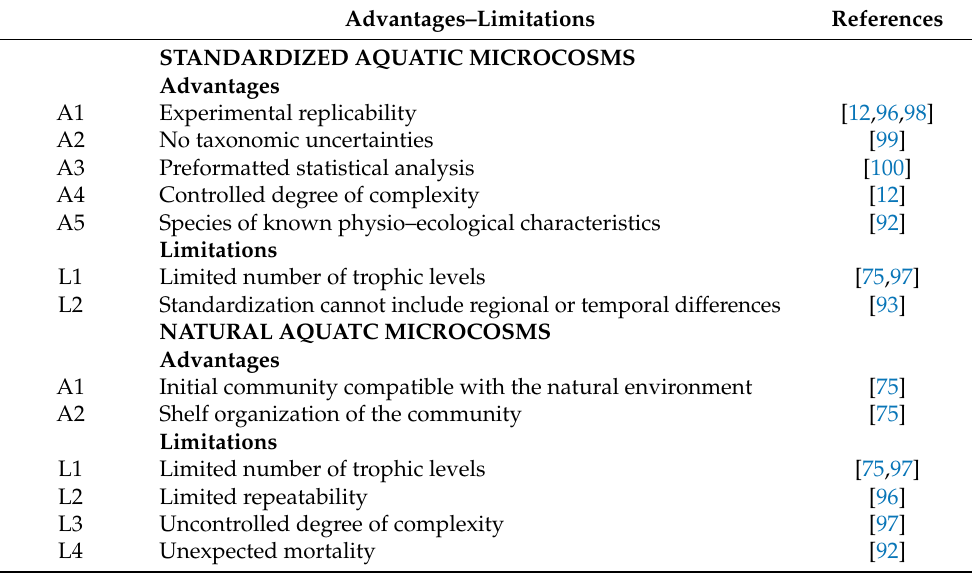
Table 4. Advantages and limitations using laboratory aquatic microcosm